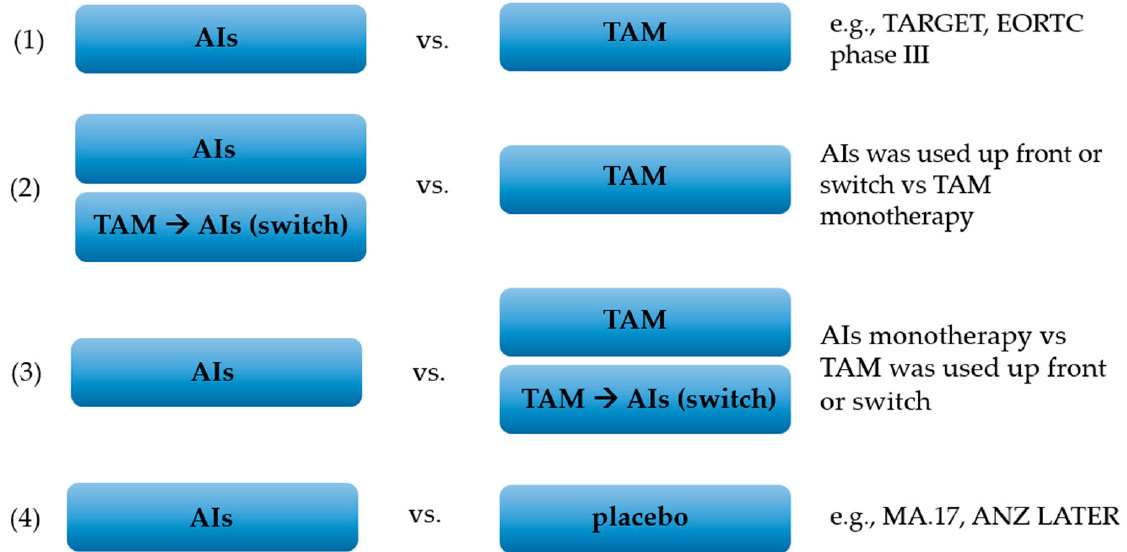
Figure 1. Visualization of groups in analyses. (1) Patients who were only using aromatase inhibitors or tamoxifen for treatment. (2) Group of patients who had been treated with aromatase inhibitors as monotherapy or in sequence with tamoxifen vs. group of patients who had only used tamoxifen for treatment. (3) Patients treated with aromatase inhibitors monotherapy vs. patents treated with tamoxifen alone or in sequence with aromatase inhibitors. (4) Patients treated with aromatase inhibitors vs. those treated with placebo.